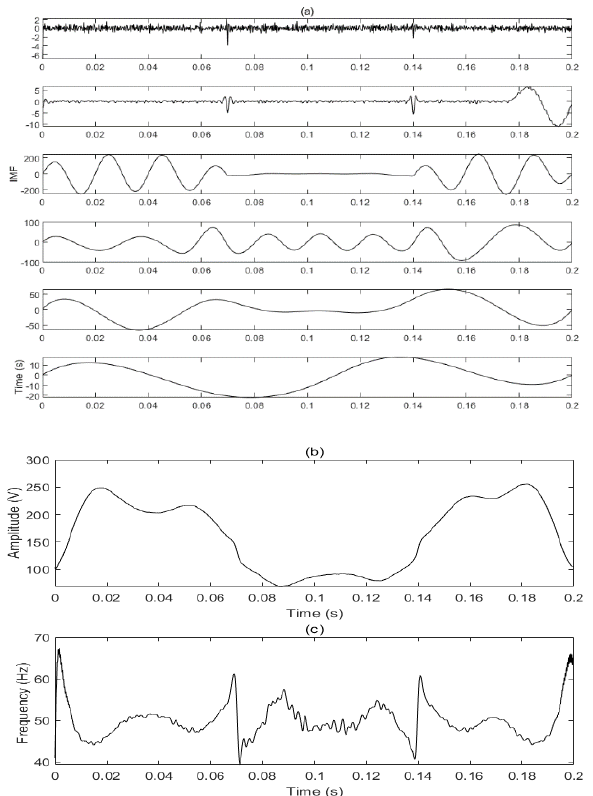
Figure 10. Voltage sag IMF components ( a ), amplitude ( b ), and frequency ( c ).